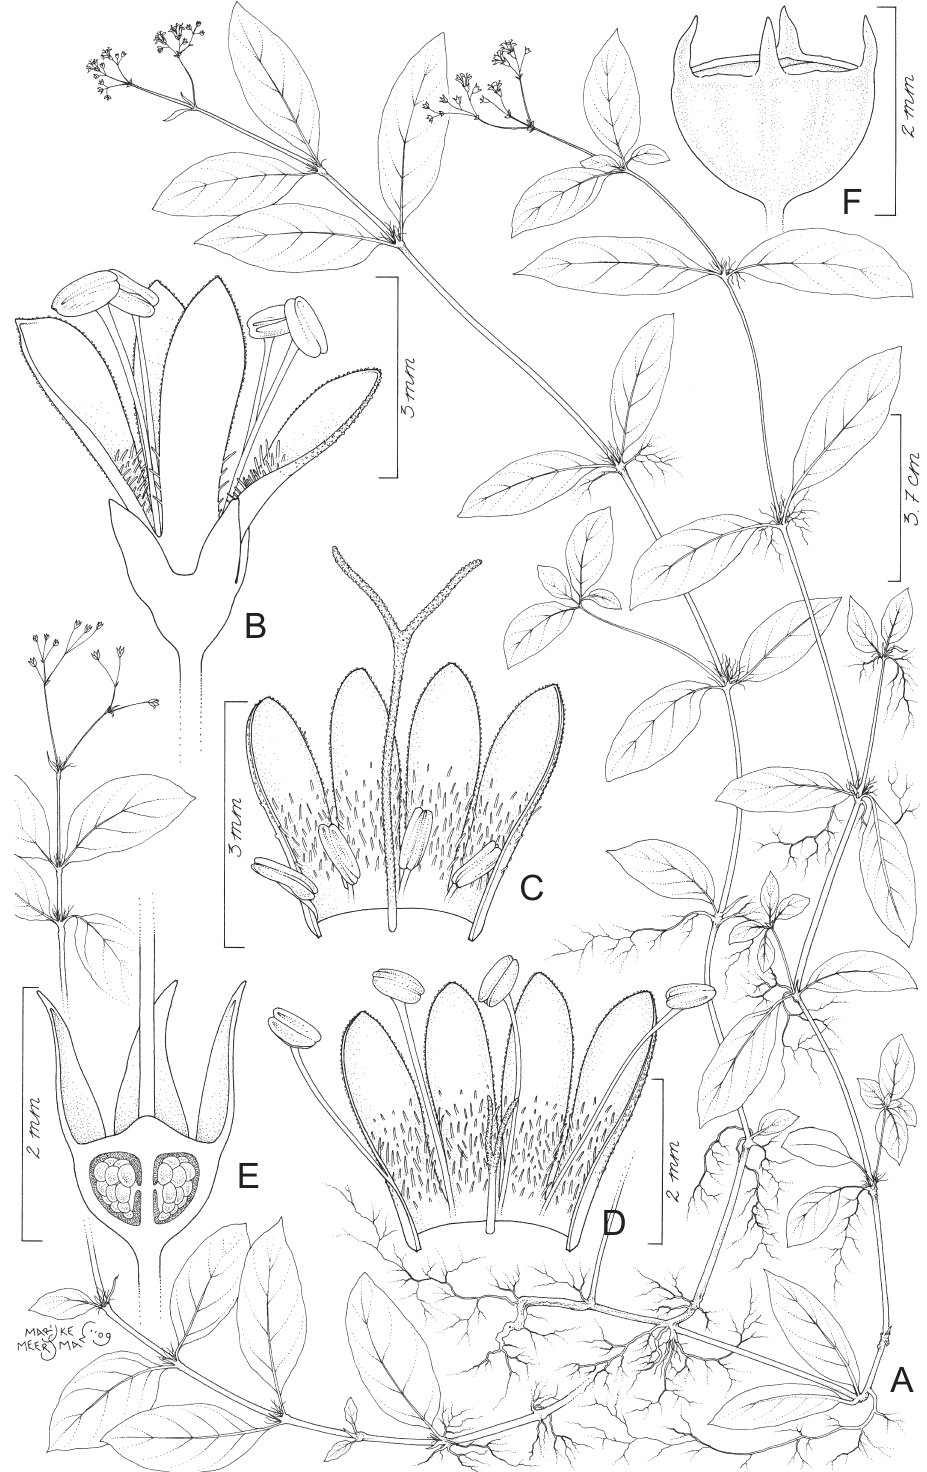
Fig. 10. Astiella homolleae Groeninckx sp. nov. A . Habit. B . Brevistylous flower. C . Open longistylous flower. D . Open brevistylous flower. E . Ovary dissected to show placentation. F . Capsule. Drawn by Marijke Meersman. A from Perrier de la Bâthie 17438 (P); B–E from Humbert & Saboureau 31739 (BR); F from Cheek & Dominic 1325